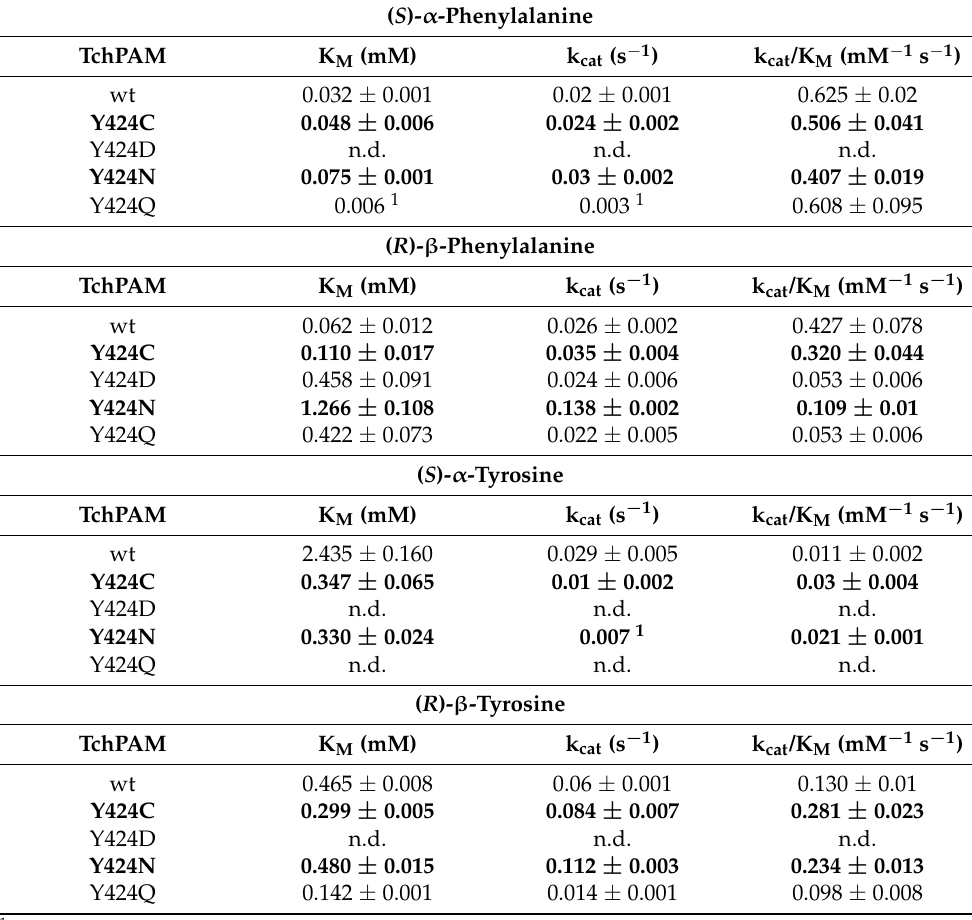
Table 1. Comparison of the kinetic parameters of wild type and mutants Tyr424Asn, Tyr424Asp, Tyr424Cys, and Tyr424Gln in ammonia elimination of various